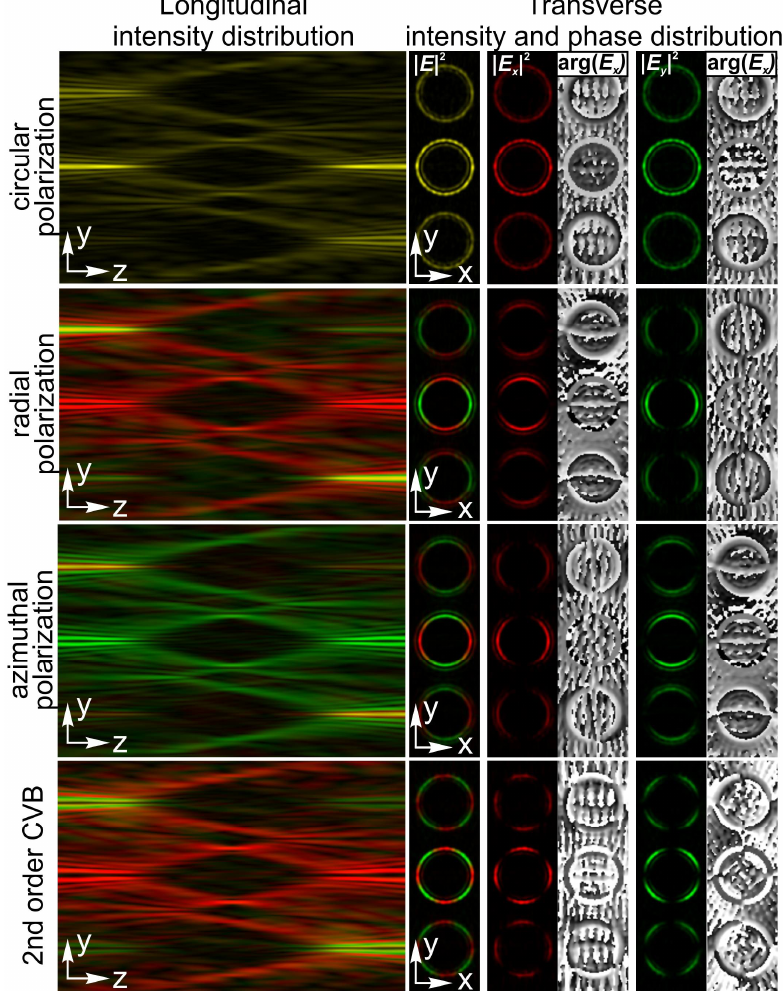
Figure 8. Demonstration of interaction of different polarization states with the combined binary and helical linear axicons of Equation (7). The red color indicates the x-component of the intensity and the green color indicates the y-component. The yellow color corresponds to circular polarization. Figure 9 shows the results of modelling and experiments for two intersecting axicons of different types (axisymmetric or spiral of different orders) illuminated by CVBs of